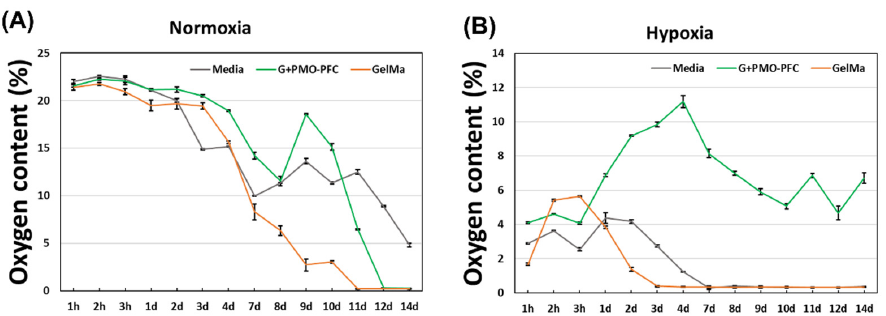
Figure 4. O 2 content of NC hydrogel scaffold under normoxia ( A ) and hypoxia condition ( B ). 3.5. Rutin Release from Rutin-Functionalized NC Hydrogel